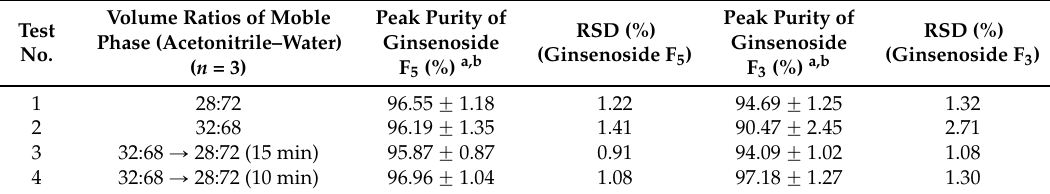
Table 2. The influence of the sample load on the separation effect of CEFBPG.